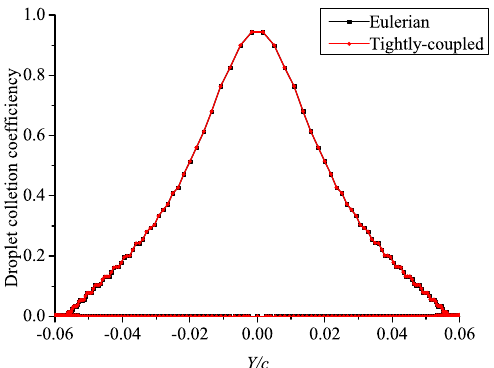
Figure 21. Distribution of the droplet collection coefficient at the initial